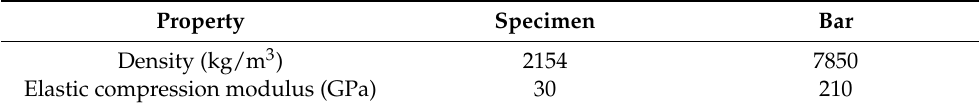
Table 1. Parameters of the Specimen and Bar.